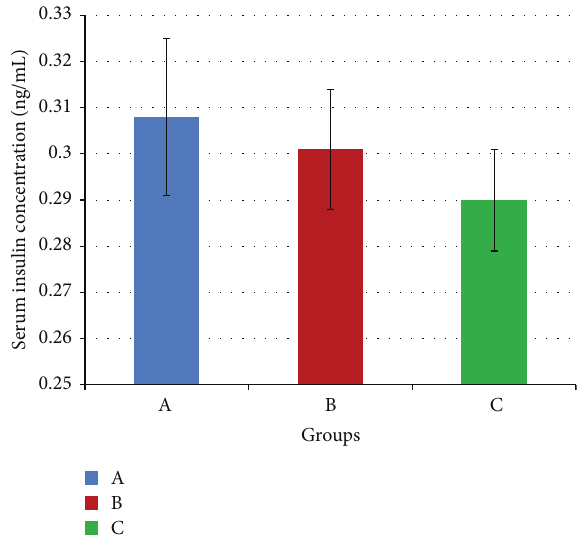
Figure 5: Mean serum insulin concentrations of rats in groups A, B, and C at the end of the four-week treatment period. Group A: control (HSD/HFD); group B: stress + HSD/HFD; group C: stress + GA + HSD/HFD. Abbreviations: GA: glycyrrhizic acid, HSD: high- sucrose diet, and HFD: high-fat